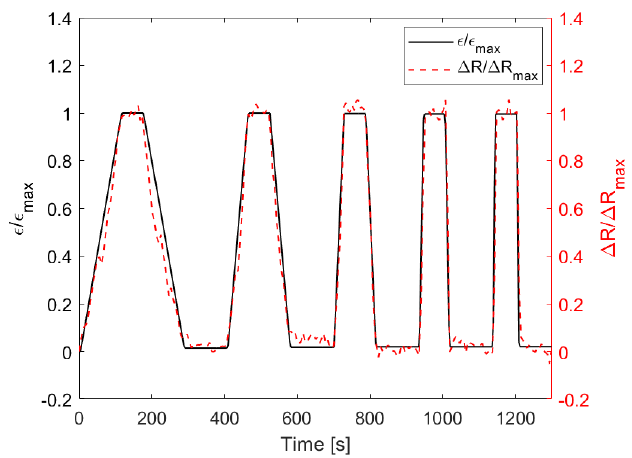
Figure 12. Variation in the electrical resistance (black lines) and GF (red lines) as a function of ε.